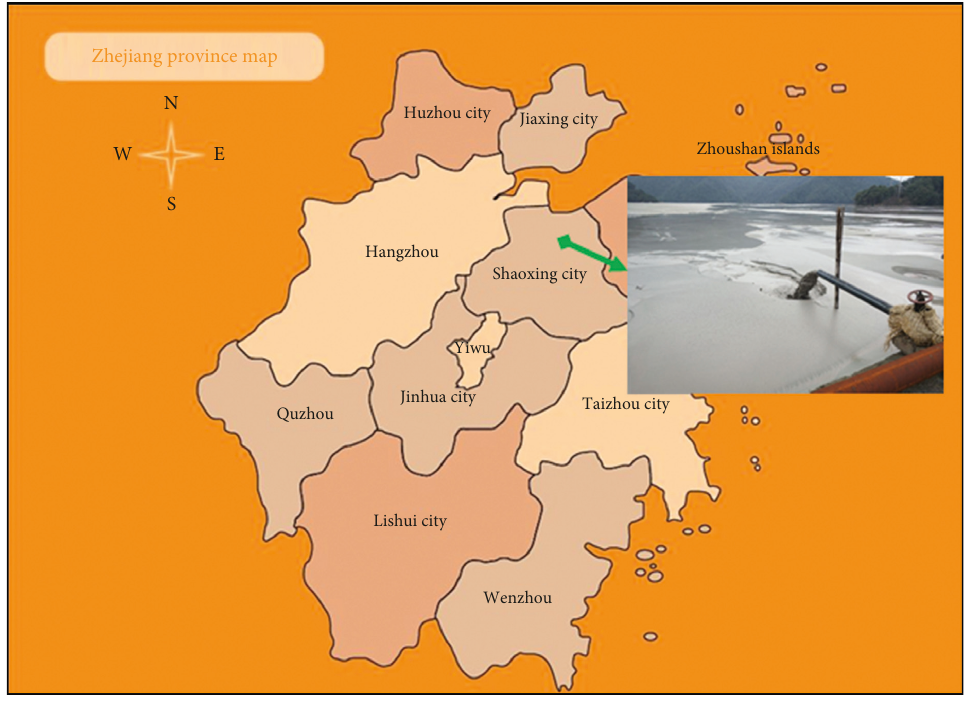
Figure 1: The position of Zhejiang Lizhu Iron tailings.